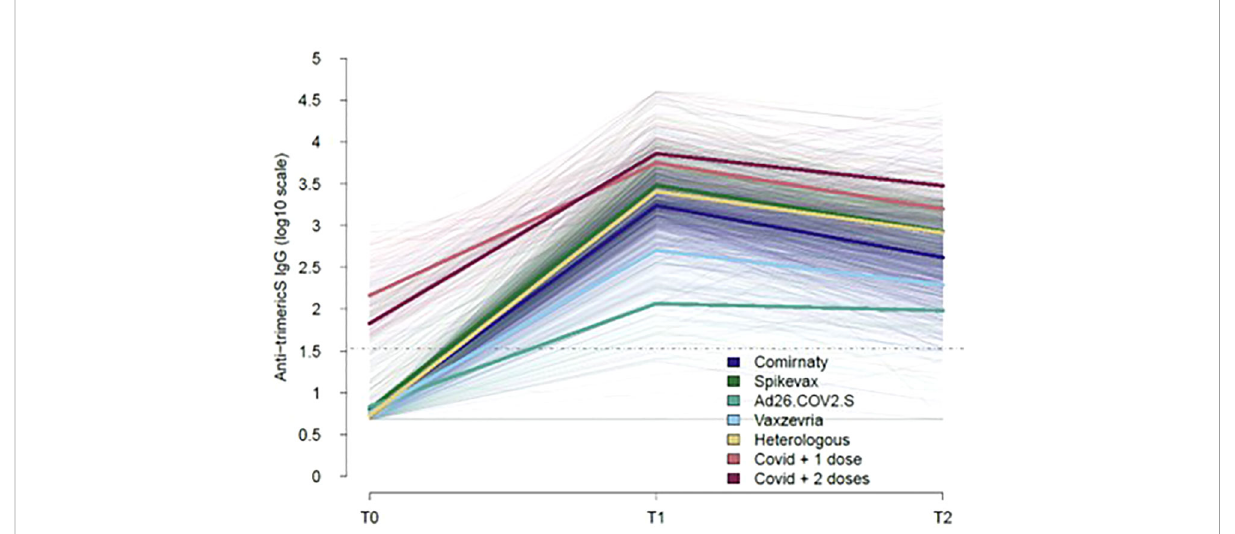
FIGURE 1 Kinetics of COVID-19 vaccine-induced IgG over time. The trajectories of serum anti-trimeric-Spike IgG (BAU/ml) for all the subjects analysed, strati fi ed by type of vaccine or previous COVID-19 diagnosis are shown (thin lines). Mean values in each group are indicated (thick lines). The dotted line represents the positivity cut-off of the serological assay (33.8